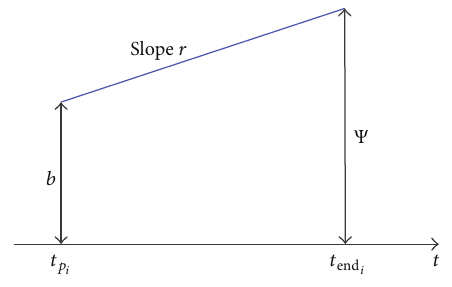
Figure 6: Service model of a HCCA centralized scheduler.